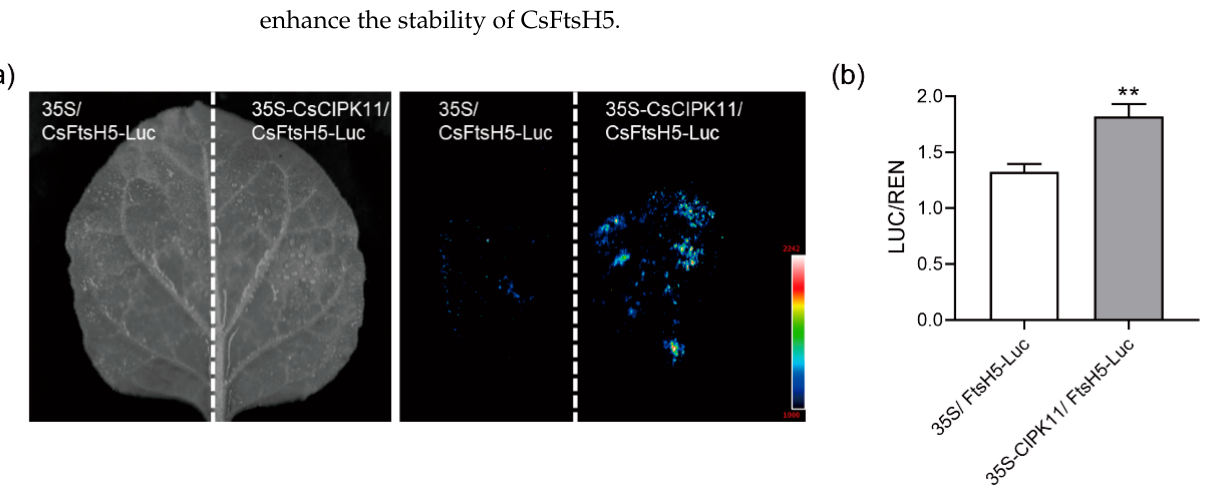
Figure 5. CsCIPK11 may stabilize the CsFtsH5 protein. ( a ) Fluorescence observations in Nicotiana benthamiana leaves that expressed 35S-CsCIPK11/35S-CsFtsH5-Luc and 35S-empty vector/35S-CsFtsH5-Luc. ( b ) Relative LUC/REN activity measurements in dual-Luciferase assays. The relative LUC/REN value is the average of six biological replicates. Error bars indicate the SEM of six biological replicates. Asterisks indicate significant differences according to t -tests (** p < 0.01).